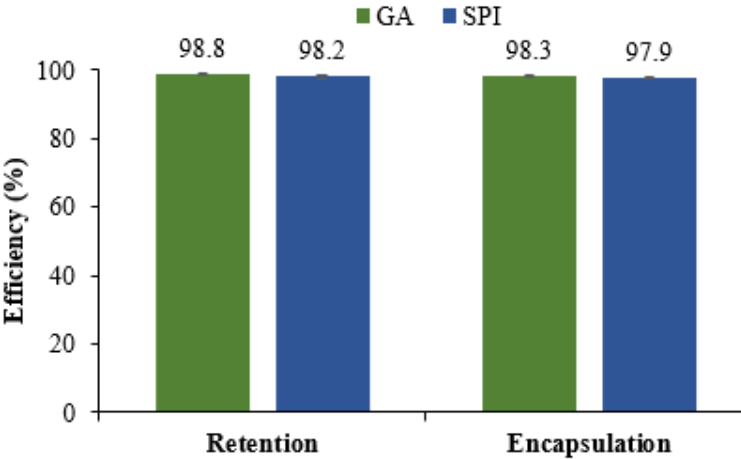
Figure 5. Retention and encapsulation efficiency of phenolic compounds (%) in the RBP microcapsules with gum arabic and soy protein isolate.